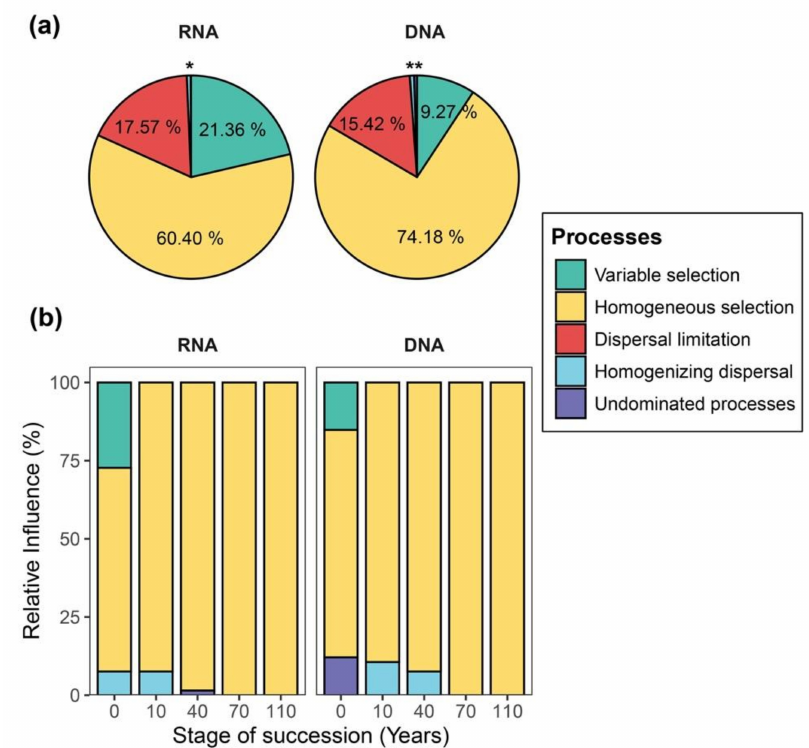
Figure 5. Pie charts and stacked-bar plots displaying the relative influences of assembly processes governing community turnover. ( a )The pie charts show the relative influence of distinct assembly processes determining the spatiotemporal variation of RNA- and DNA-inferred communities. ( b ) Stacked-bar plots display the relative influences of distinct assembly processes structuring the temporal variation of bacterial communities in each successional stage based on both RNA- and DNA-based approaches. * indicates the influence of homogenizing dispersal and undominated processes for the turnover of RNA-inferred communities to be 0.62% and 0.06%, respectively. ** indicates the influence of homogenizing dispersal and undominated processes for the turnover of DNA-inferred community to be 0.68% and 0.45%,